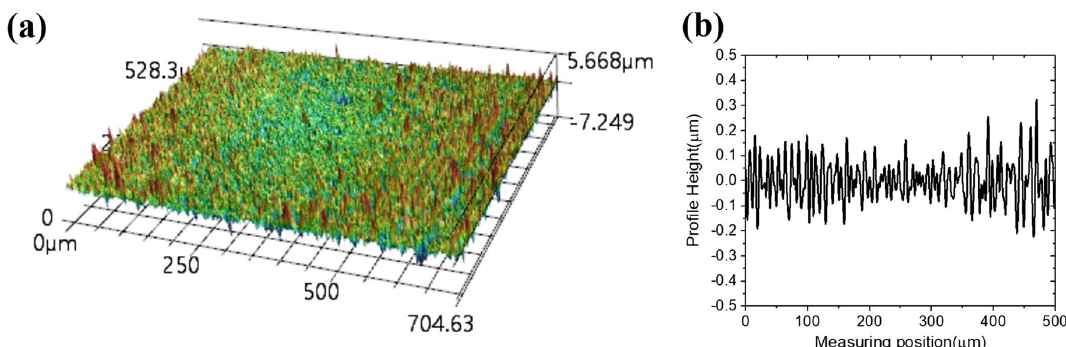
Figure 12. Confocal laser microscope measuring results of the resistive double square loops filled with the conductive ink machined by the planing process. ( a ) 3D image of ink surface after removing the overflowed conductive ink, ( b ) roughness profile of the ink surface after removing the overflowed conductive